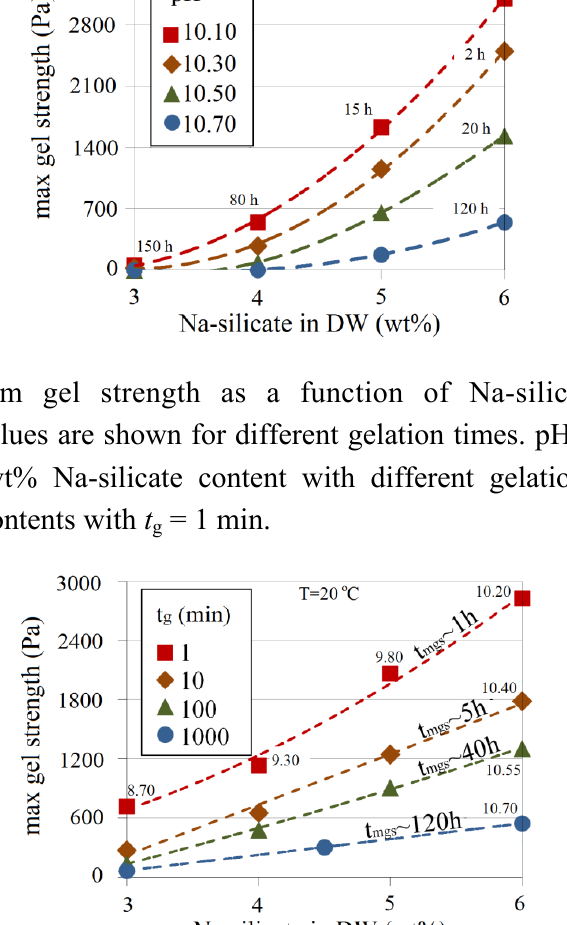
Figure 19. Maximum gel strength as a function of gelation time, Na-silicate (wt%) and pH.